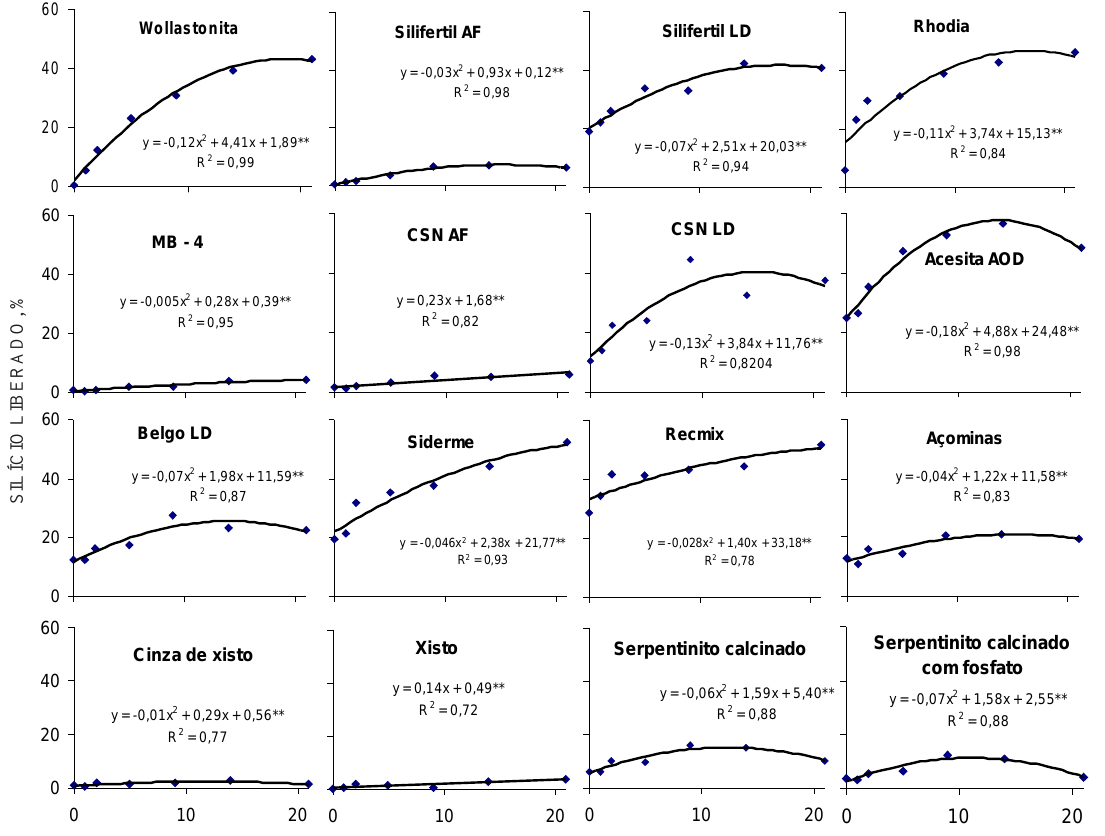
Figura 1. Solubilidade percentual em relação ao Si total de cada fonte, considerando o tempo de repouso. ** significativo a 1